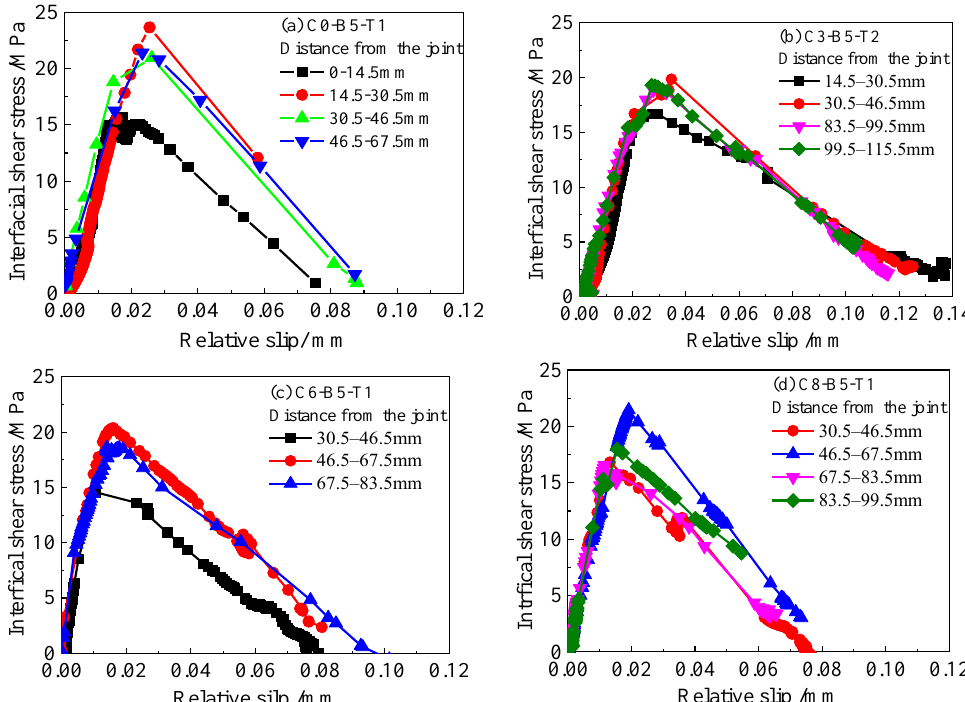
Figure 6. Typical bond–slip relationships for the CFRP plate externally bonded to the corroded steel plate with different corrosion durations and adhesive thicknesses: ( a ) specimen C0-B5-T1, ( b ) specimen C3-B5-T2, ( c ) specimen C6-B5-T1, and ( d ) specimen